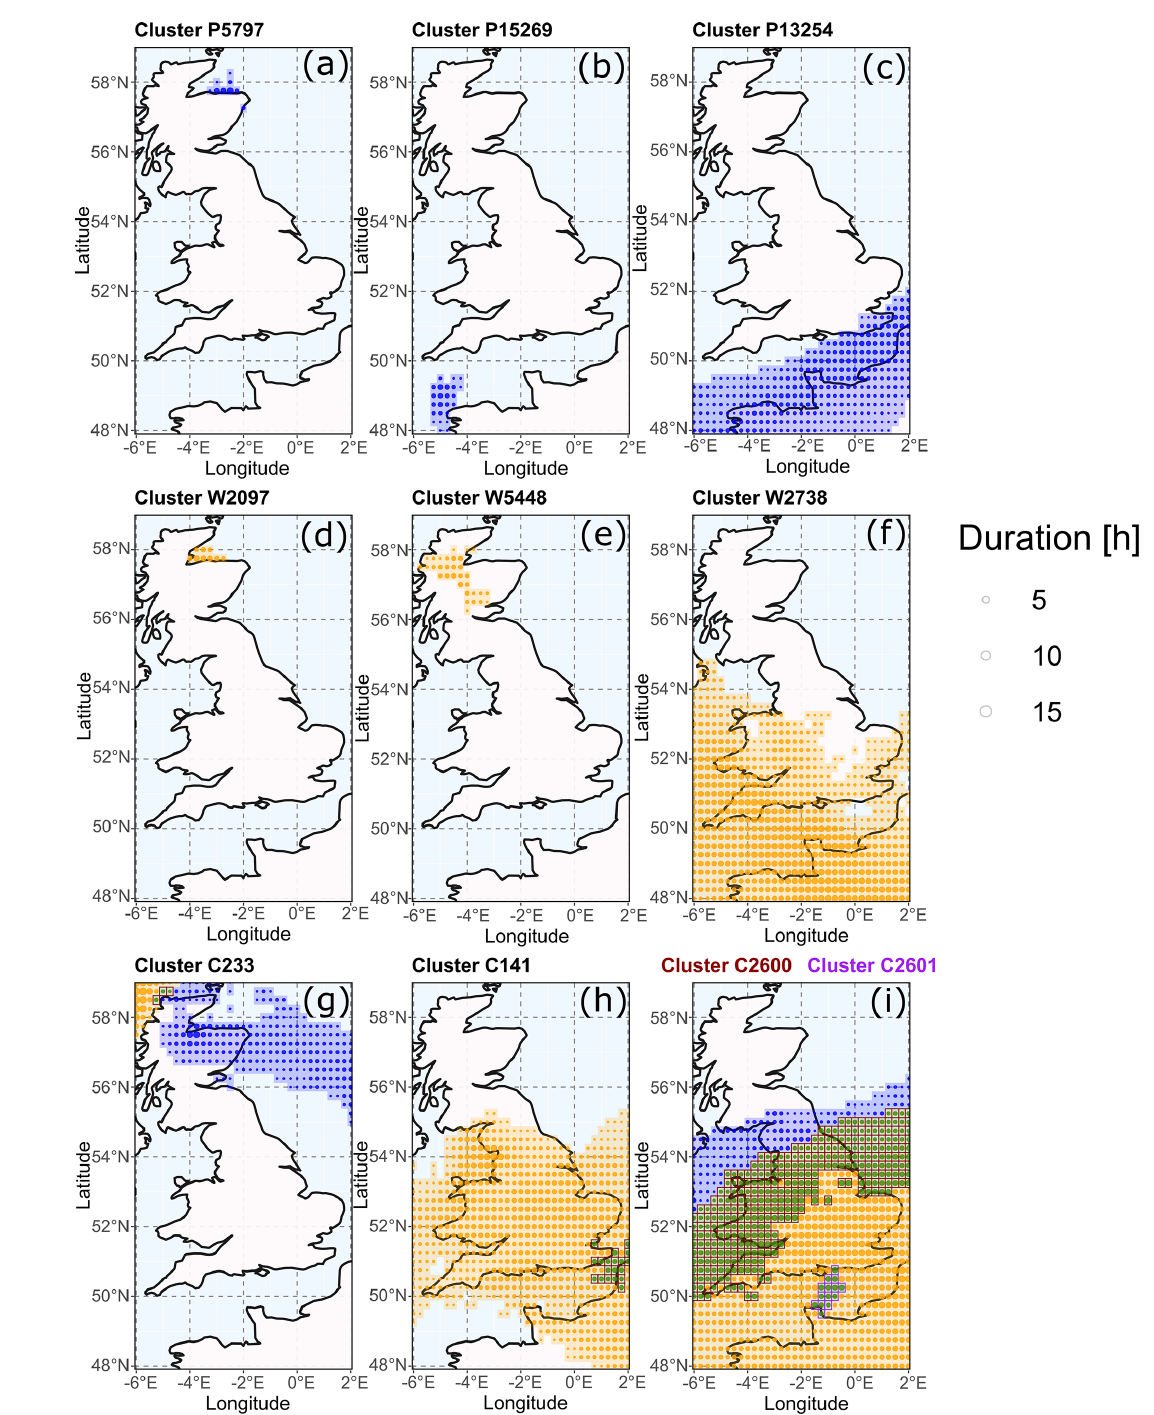
Figure 8. Footprints of 10 example natural hazard clusters from the ERA5 Hazard Cluster Database (Supplement 3): three precipitation clusters (a–c) , three wind clusters (d–f) , and four compound hazard clusters (g–i) detected by the SI–CH methodology proposed in this paper. The cluster ID ( P = precipitation, W = wind, C = compound) is given at the top of each graph. The compound clusters shown include one P and one W cluster: (g) C 233 = P 1162 and W 387; (h) C 141 = PR 766 and W 220; (i) C 2600 = P 10041 and W 3717; (i) C 2601 = P 10042 and W 3717. W 3717 is shared by both compound clusters C 2600 and C 2601. Clusters with areas that are small (footprint < 9 cells) are shown in the left column (a, d, g) , medium (19 cells < footprint < 32 cells) in the middle column (b, e, h) , and large (footprint > 316 cells) in the right column (c, f, i) . The definition of small, medium, and large for single and compound hazard clusters is derived from the quantiles of the footprint distributions ( q 10 , q 50 , q 95 ). Circle size represents the duration of single or compound hazard clusters in each cell. Earth Syst. Dynam., 13, 993–1020, 2022